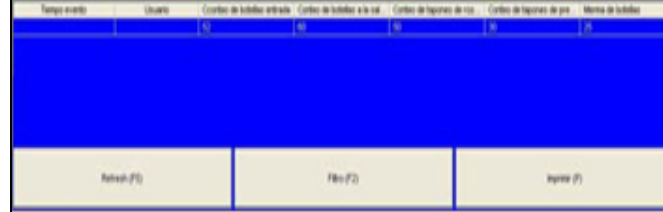
Figura 9: Pantalla del data loger. Fuente: Los Autores,